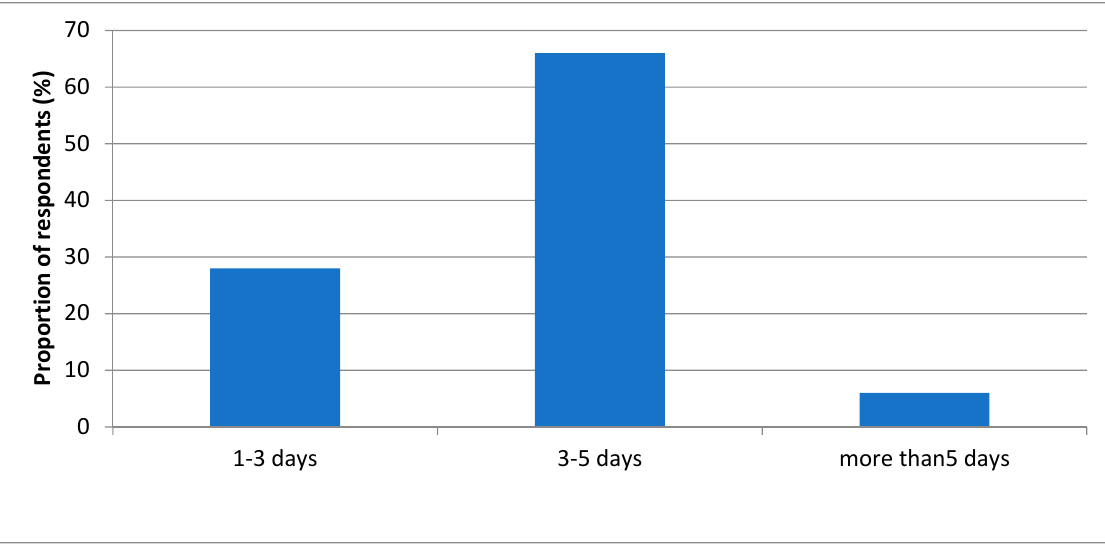
Figure 7. Duration of selling fruits by retailers ( n = 50).